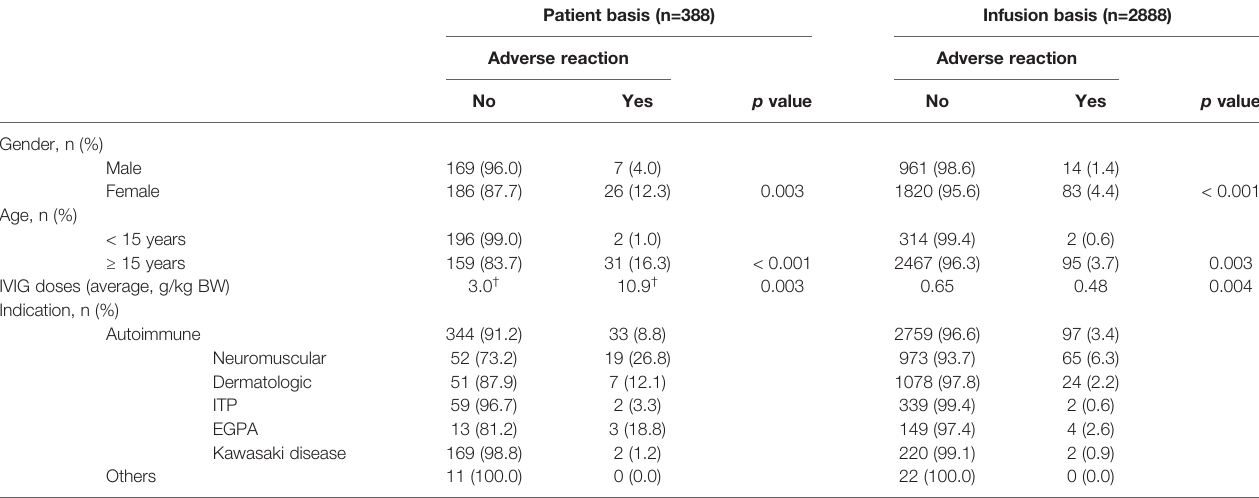
TABLE 4 | Factor-speci fi c incidences of adverse reactions to high-dose IVIG*.